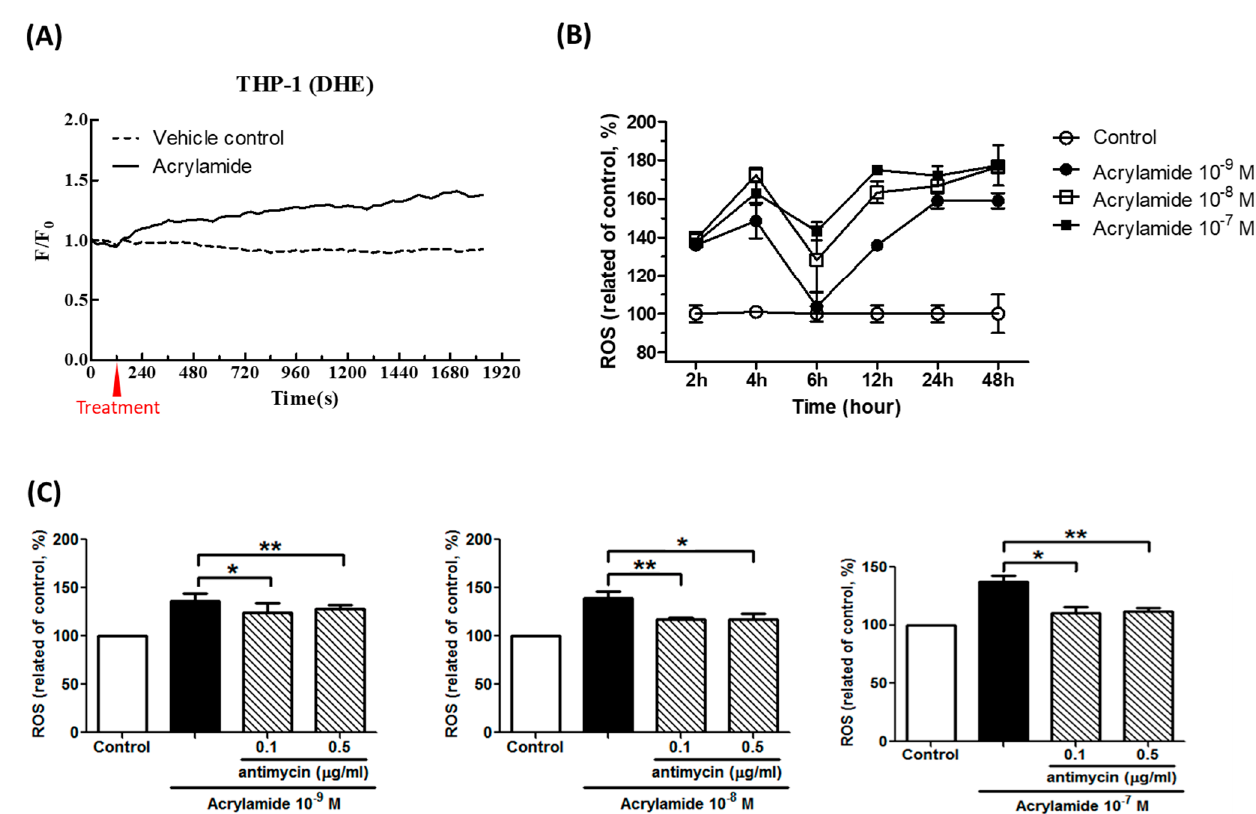
Figure 1. Acrylamide induced reactive oxygen species (ROS) production in THP-1 cells. ( A ) Acrylamide (10 − 9 M) immediately induced ROS in THP-1 cells. The ROS was detected by dihydroethidium (DHE) staining. ( B ) The pre-treatment of acrylamide (10 − 9 M~ 10 − 7 M) significantly induced ROS expression in THP-1 cells at 2, 4, 12, 24 and 48-h, but less in 6-h. ( C ) The pre-treatment of antimycin A, a complex III of respiratory chain inhibitor, suppressed acrylamide-induced ROS generation in THP-1 cells in 2 h. * p < 0.05, ** p < 0.01, by the Kruskal-Wallis test; n = 9, means ± SD.